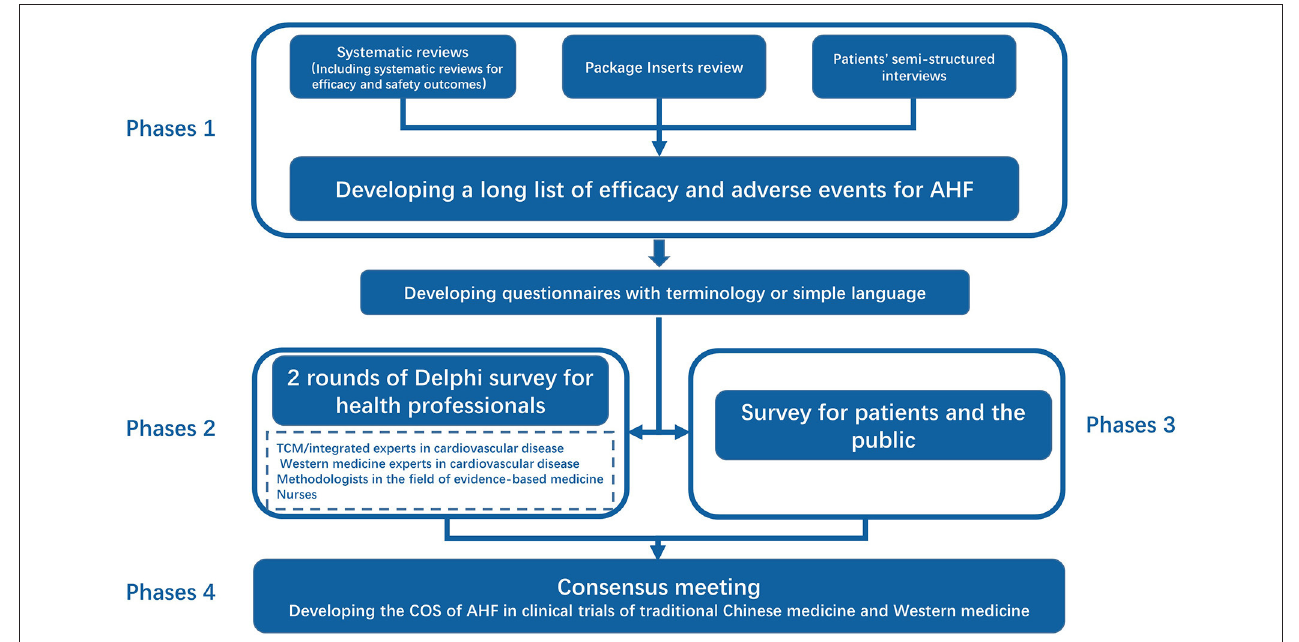
FIGURE 2 | The flowchart of the